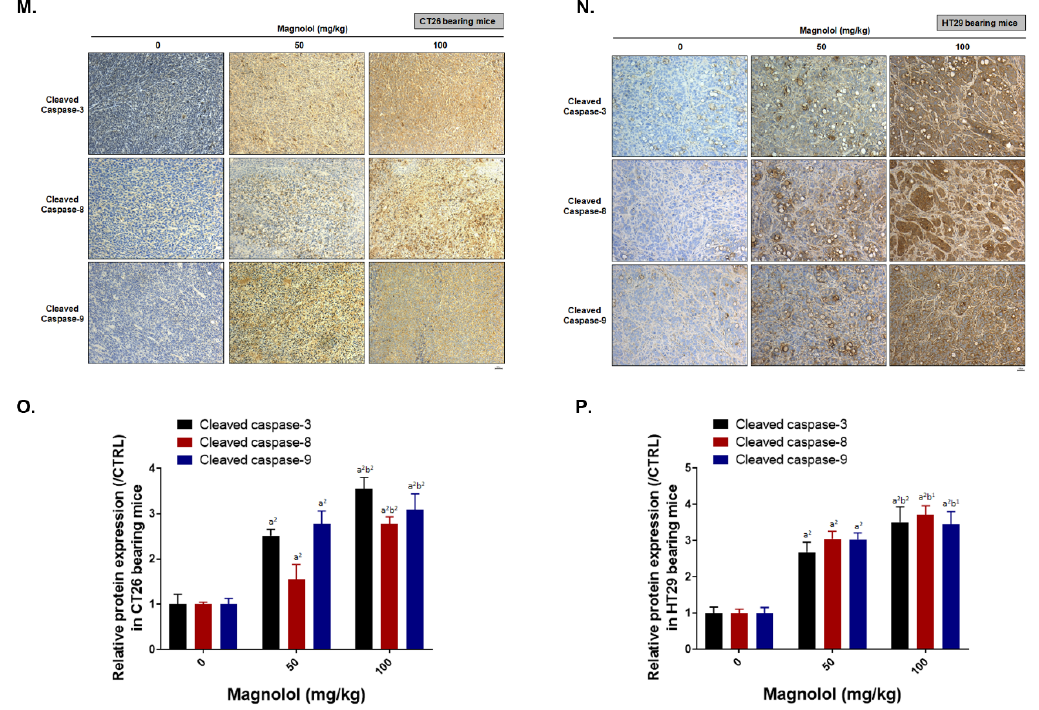
Figure 6. CRC growth is suppressed by magnolol via inhibition of PKC δ / NF- κ B pathway. ( A – D ) One represented IHC image and protein phosphorylation levels of PKC δ , ERK, AKT, and NF- κ B in CT26 and HT29 tumor. ( E – H ) One represented IHC image and proteins expression quantification results of C-FLIP and MCL-1 in CT26 and HT29 tumor. ( I – L ) One represented IHC image and proteins expression quantification results of MMP-9, VEGF and CyclinD1 proteins in CT26 and HT29 tumor. ( M – P ) One represented IHC image and proteins expression quantification results of cleaved-caspase-3, -8 and -9 in CT26 and HT29 tumor. Three tumor tissues are performed with IHC staining from each group and repeated twice. (a 1 , a 2 p < 0.01 vs. 0 mg / kg magnolol; b 2 p < 0.01 vs. 50 mg / kg magnolol).